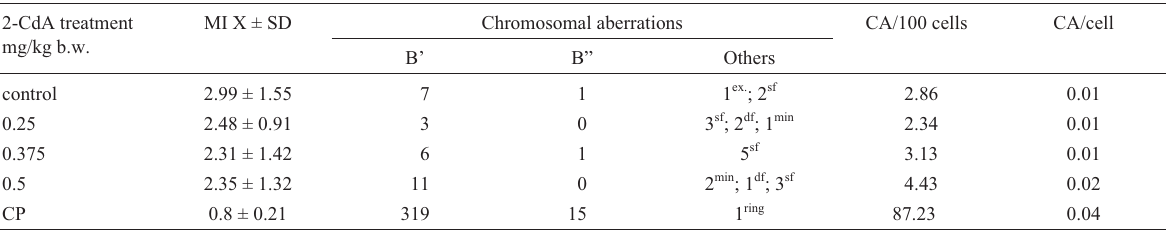
Table 3 - MI and CA frequency observed in Balb/c mice bone marrow cells, intraperitoneally treated with 2-chlorodeoxyadenosine (2-CdA) and their respective negative (water) and positive (cyclophosphamide-CP) controls. A total of 1000 cells/animal were analyzed for the MI (8000 cells/treatment) and 100 metaphases/animal (800 metaphases/treatment) for CA. 2-CdA treatment mg/kg